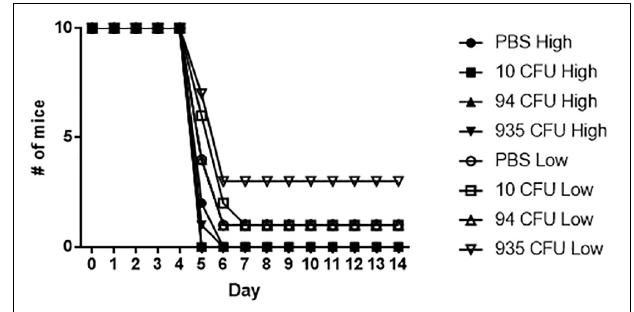
FIGURE 12 | Fn slt does not protect against re-challenge with Ft Schu S4. Groups of mice receiving 10, 94, and 935 CFU of Fn slt vaccine or PBS only ( n = 10) were challenged 28 days post-vaccination with either a high dose (37 CFU) or low dose (6 CFU) of Ft Schu S4 via the intranasal route. Log rank comparison and survival regression analyses identified no significant difference between vaccinated and control